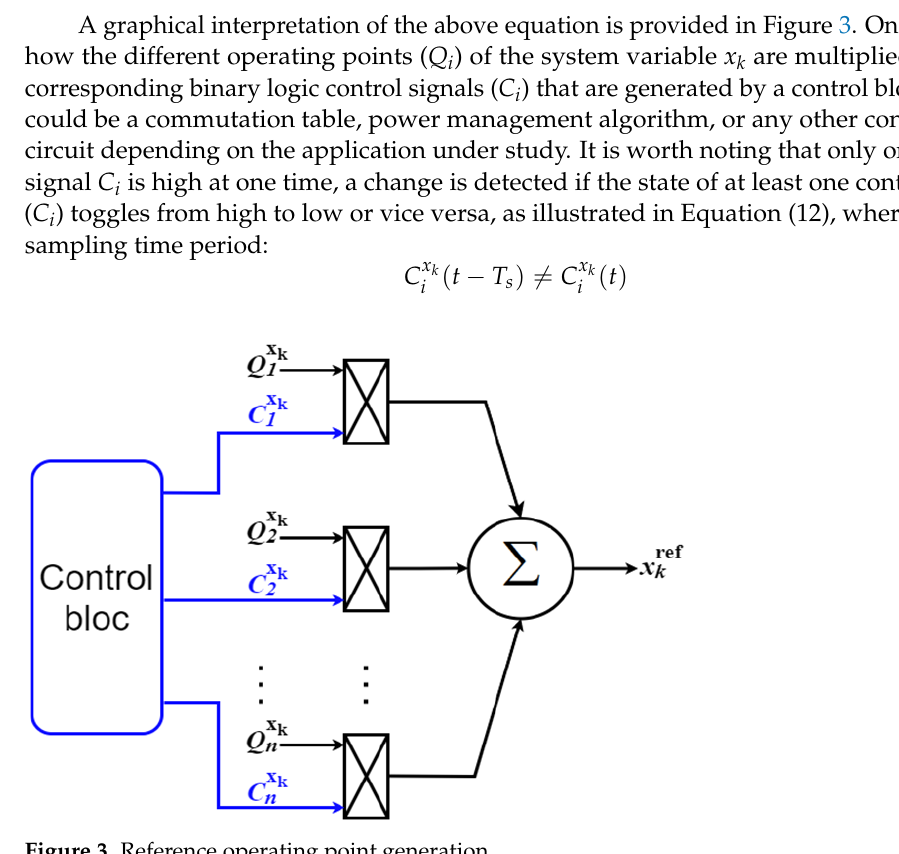
Figure 3. Reference operating point generation.